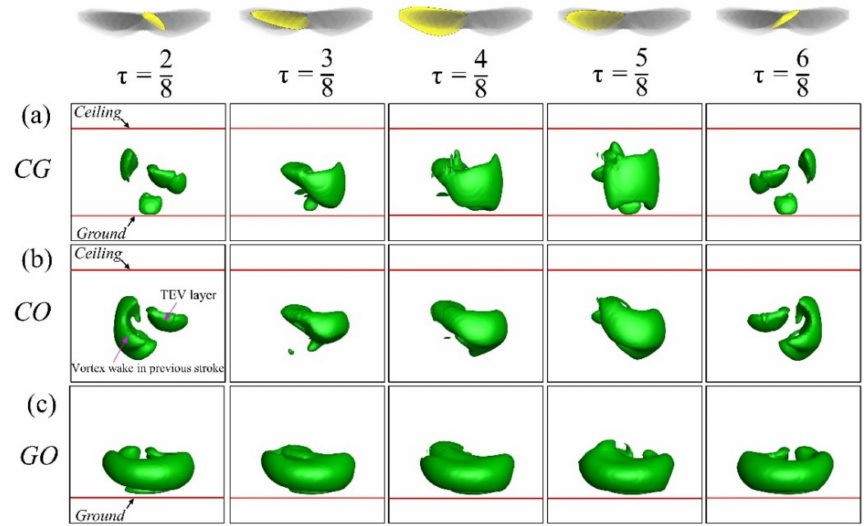
Figure 16. Side view of the iso-Q surface (green) with vortex wake for ( a ) the combined ceiling and ground case (referred to as CG ); ( b ) the ceiling-only case (referred to as CO ); and ( c ) the ground-only case (referred to as GO ) at D / c = 4.0 for different times at Re = 10. The red line means the position of the ceiling and/or the ground. The non-transparent wing in the first row indicates the position of the wing at the corresponding time.